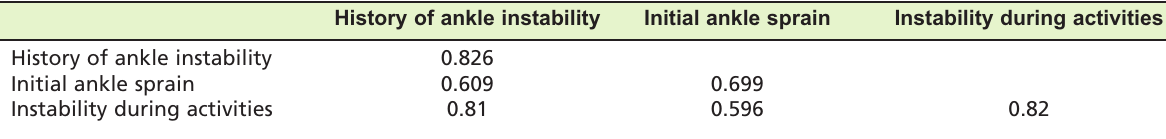
The square root of the average variance extracted (AVE) Table IV: